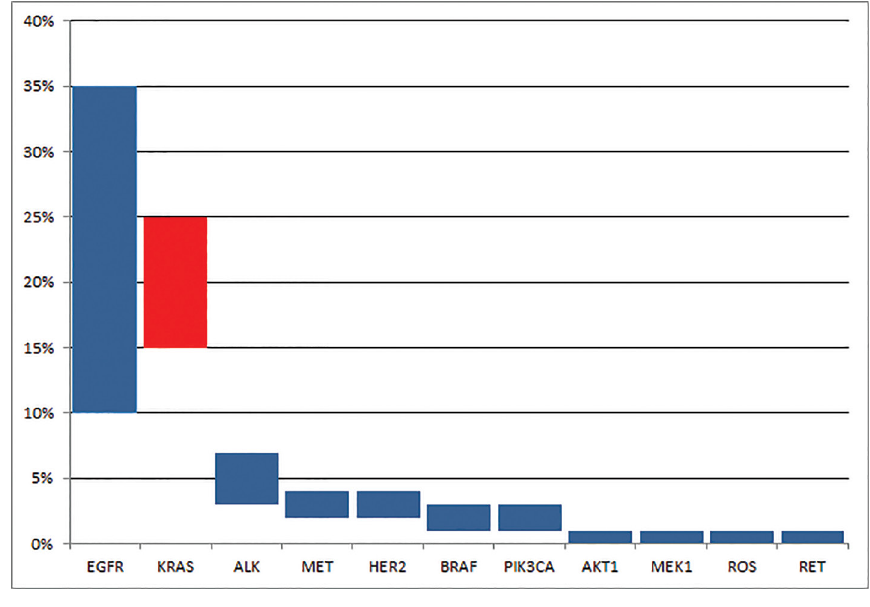
Figure 1. Frequency of driver mutations in NSCLC. Red: KRAS genotypes; blue: other genotypes. (Data obtained from https://mycancergenome.org/ on 2 June